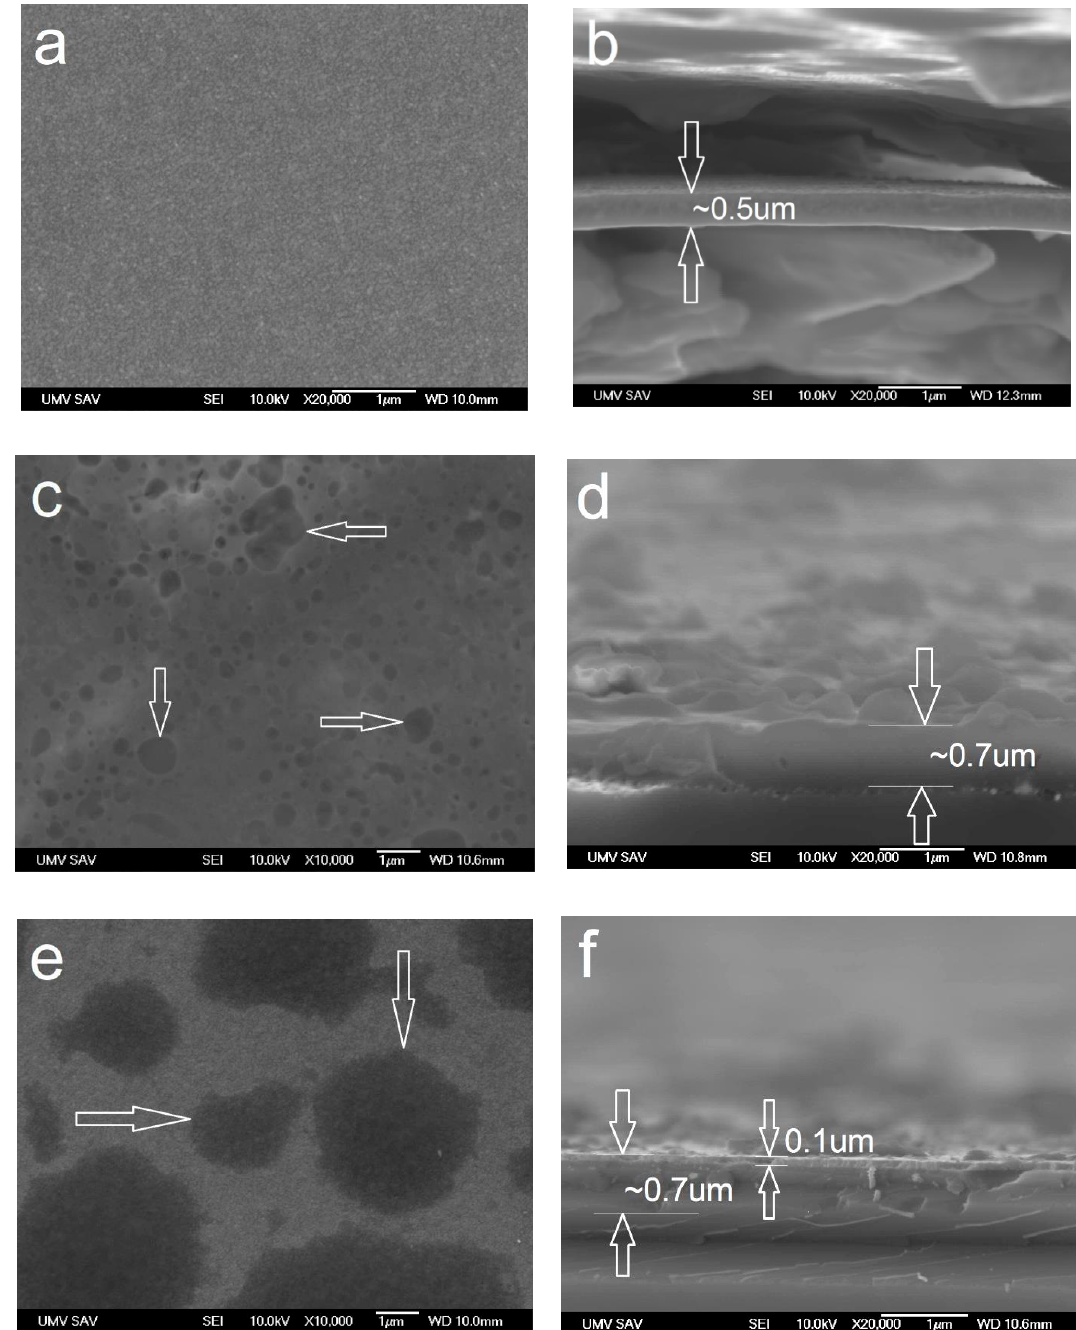
Figure 9. Morphology of the surface and cross-sectional brake of WC / C coating (based on SEM images) deposited with N 2 (added gas): ( a , b ) RT and annealed at ( c , d ) 500 °C and ( e , f ) 800 °C.